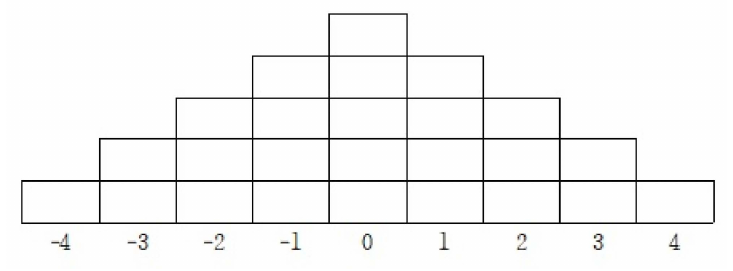
Figure 1. Q − sorting response